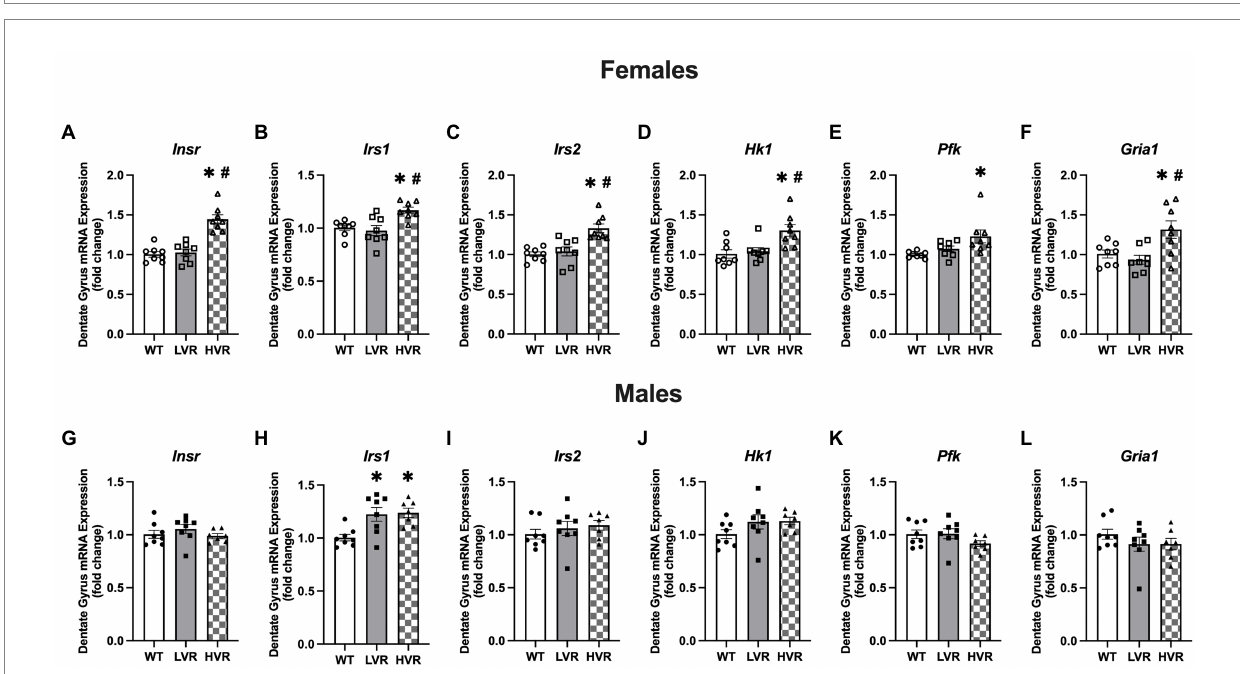
FIGURE 5 Female HVR have enhancements in brain insulin signaling and glucose metabolism. (A–F) Transcript expression levels of Insr , Irs1 , Irs2 , Hk1 , Pfk , and Gria1 in female WT ( N = 8), LVR ( N = 8), and HVR ( N = 7). (G–L) Transcript expression levels of Insr , Irs1 , Irs2 , Hk1 , Pfk , and Gria1 in male WT ( N = 8), LVR ( N = 8), and HVR ( N = 7). * Denotes significant Tukey post-hoc difference relative to WT following one-way ANOVA. # Denotes significant Tukey post-hoc difference relative to LVR following one-way ANOVA. Values expressed as mean +